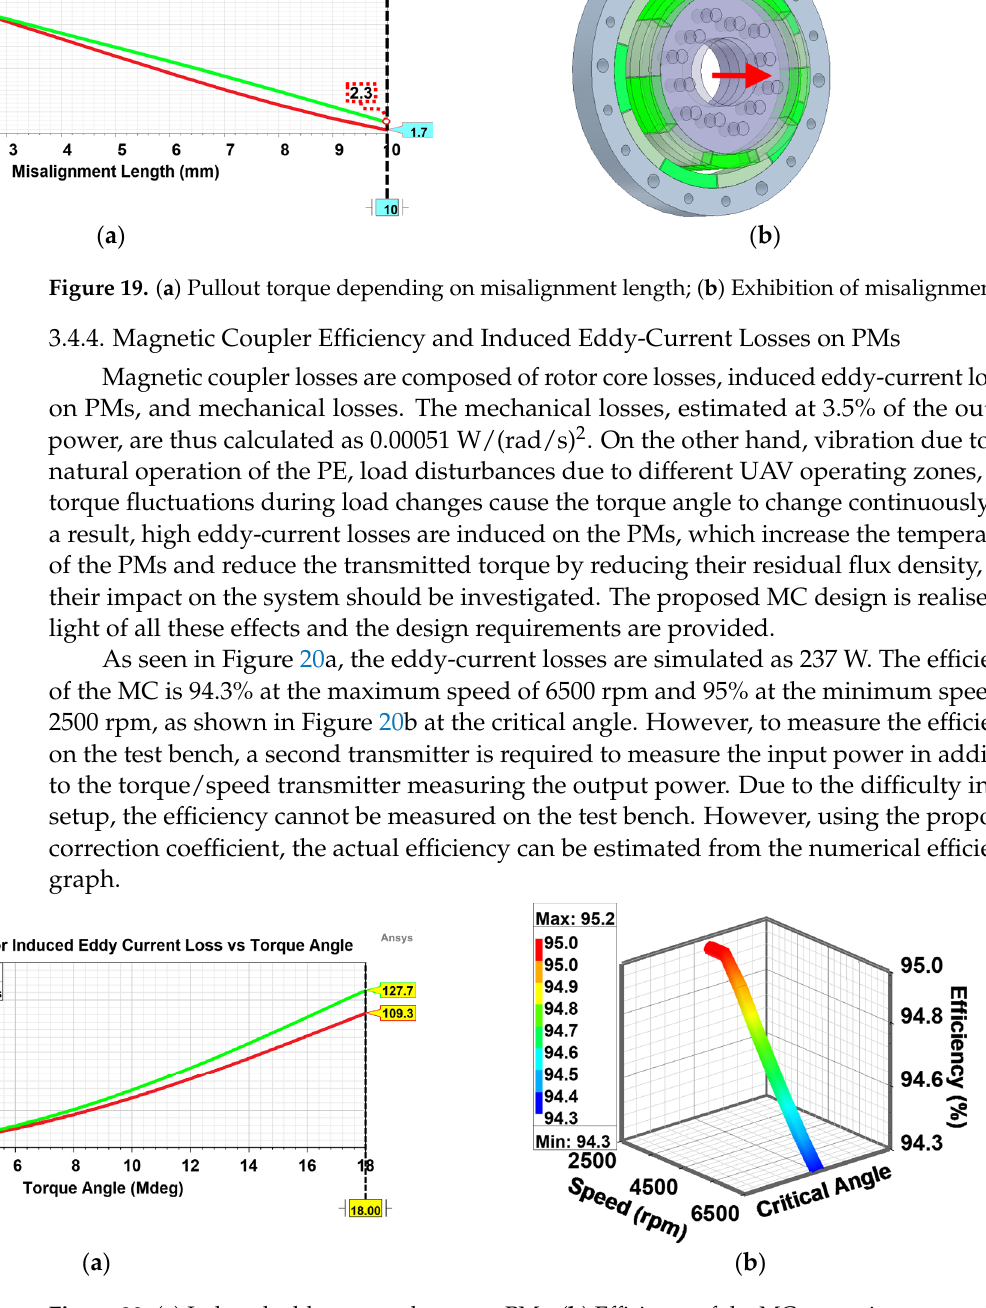
( b ) Figure 18. Investigation of: ( a ) Effect of different rotor materials on torque; ( b ) Air gap flux density. 3.4.3. Study of Pullout Torque depending on Misalignment Length As part of the worst-case scenario analysis, it is essential to examine the reduction in the pullout torque due to the misalignment length caused by the propeller pulling the system forwards until it is unable to generate thrust in the event of any extreme bearing